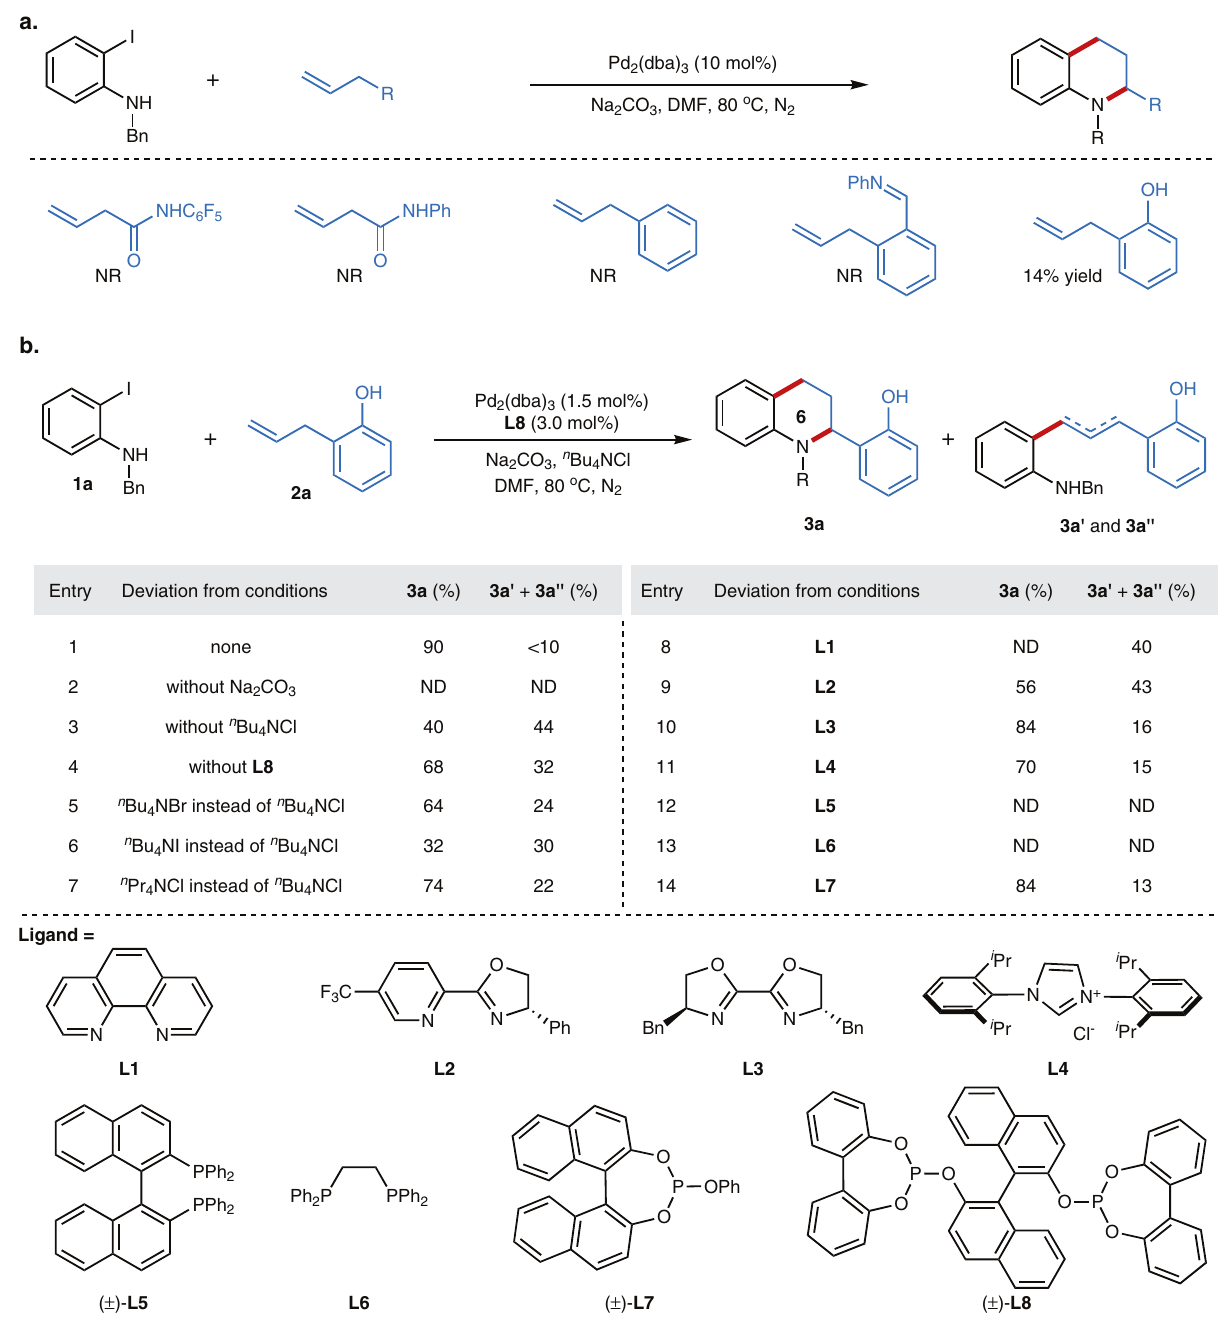
N , N -dimethylformamide; dba, dibenzylideneacetone; NR, no reaction; ND, not detected. The yield was determined by analysis of the crude 1 H NMR using dibro- momethane as the internal standard. See Supplementary Information for experi- mental